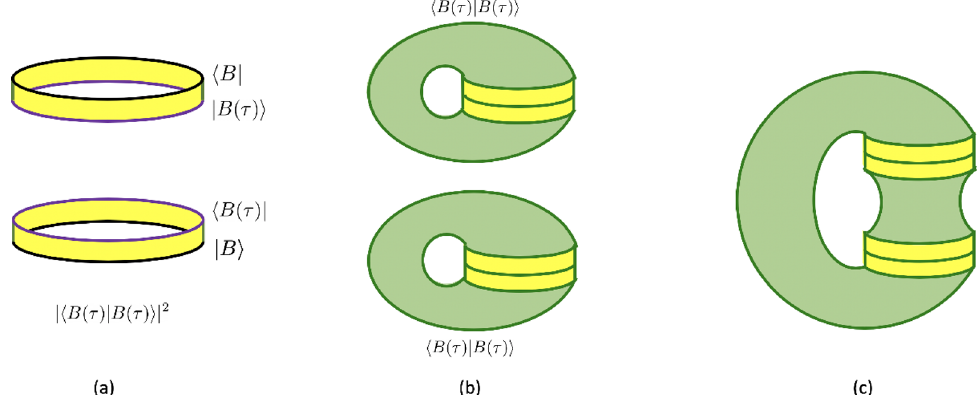
Figure 31 . We consider the computation of h B ( τ ) | B ( τ ) ih B ( τ ) | B ( τ ) i . In (a) we display the holographic dual with boundary states. Starting with the state | B i we evolve by time τ to get | B ( τ ) i and then overlap it with h B ( τ ) | . We do the same with the bra. In (b) we have the